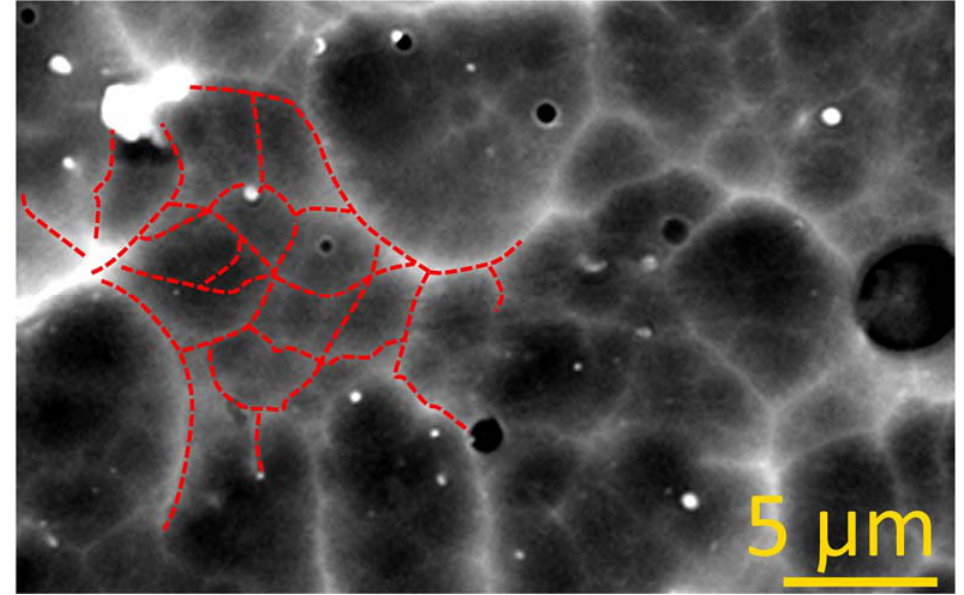
Figure 3. Cluster structure of the surface of the Ti–TiN–(Ti,Cr,Al)N coating after deposition.